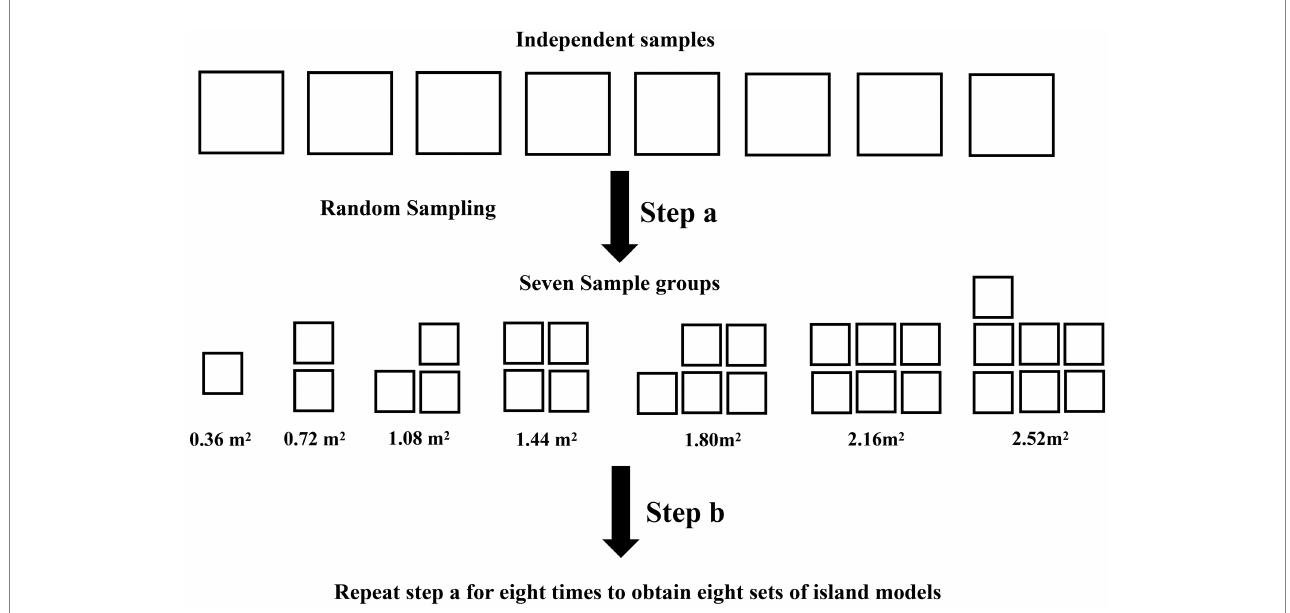
FIGURE 1 Schematic graph of sampling. Each box in the graph represents one filter paper. The area of each independent sample is 0.36 m 2 . Perform Step a to obtain seven sample group. Perform step b eight times to obtain eight island models, each containing seven sample